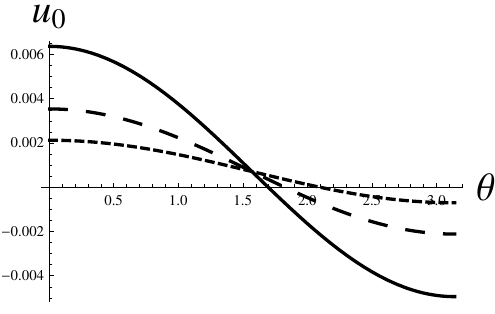
Figure 4. Dependence of u 0 from (4.4) on the intensity | α | and the direction θ of the dipole (0 ≤ θ < π ) when α = | α | e iθ for a 2 = − a 1 = 0 . 5, δ = 10 − 6 . Data are for: α = 0 . 4 10 − 5 (solid line); α = 0 . 2 10 − 5 (long dashed line); α = 10 − 6 (short dashed